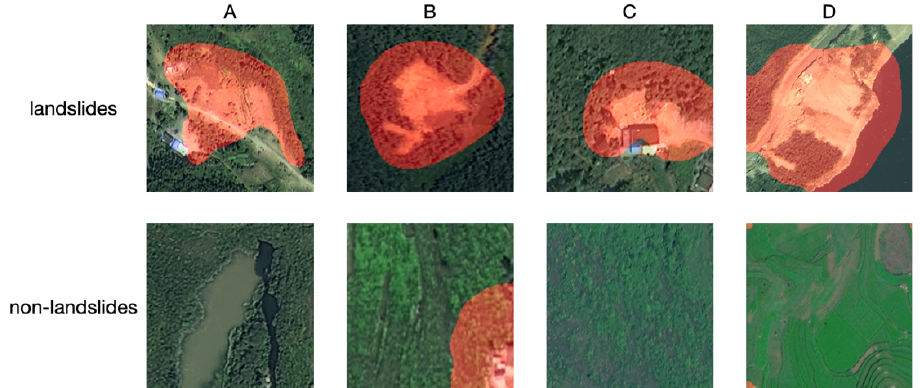
Figure 5. Segmentation results of CAM method. We have used 4 pairs of samples for test. ( A , C , D ) show that the results are all right, and ( B ) shows that the algorithm incorrectly recognized the house as